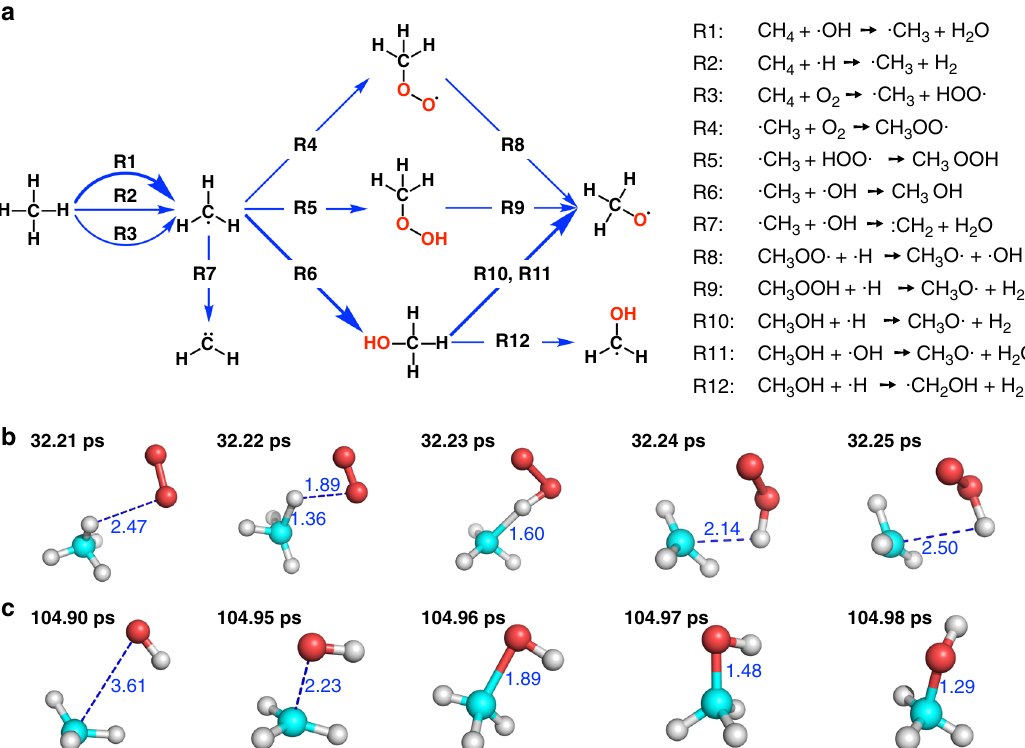
Fig. 2 The initial stage of combustion. a Main reaction pathways in the initial stage of the combustion. b A real-time trajectory showing the reaction process of hydrogen abstraction from methane by O 2 . Atoms in cyan, red and gray colors are carbon, oxygen and hydrogen, respectively. c A real-time trajectory showing the reaction process leading to the creation of methanol. De fi nition of colored atoms is the same as in ( b ).